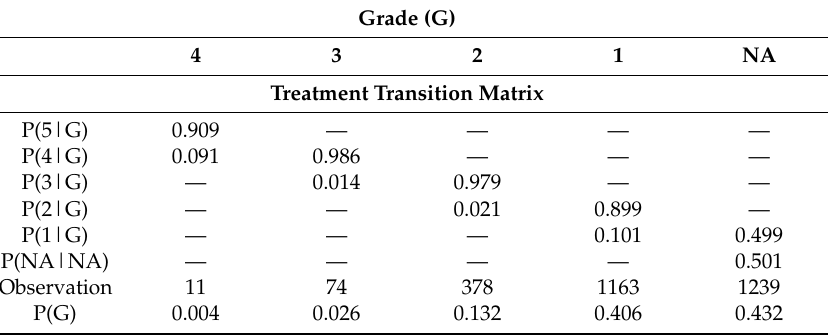
Table A1. Transition matrices (ages